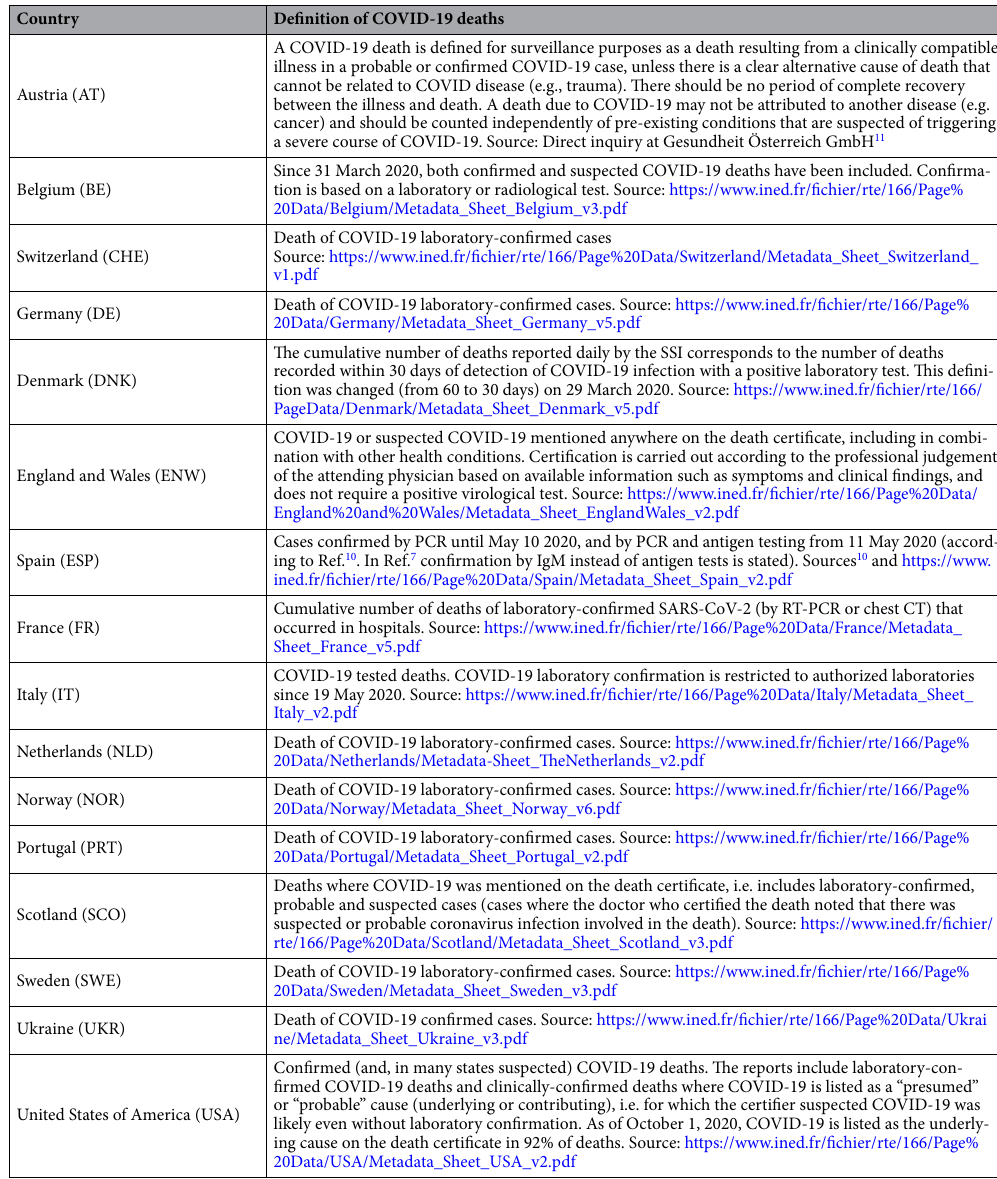
Table 1. Country overview and description of COVID-19 mortality definitions. Population size, number of COVID-19 deaths, the definition of COVID-19 deaths. If not indicated otherwise, the definition of COVID-19 deaths is taken from INED’s metadata sheets 7